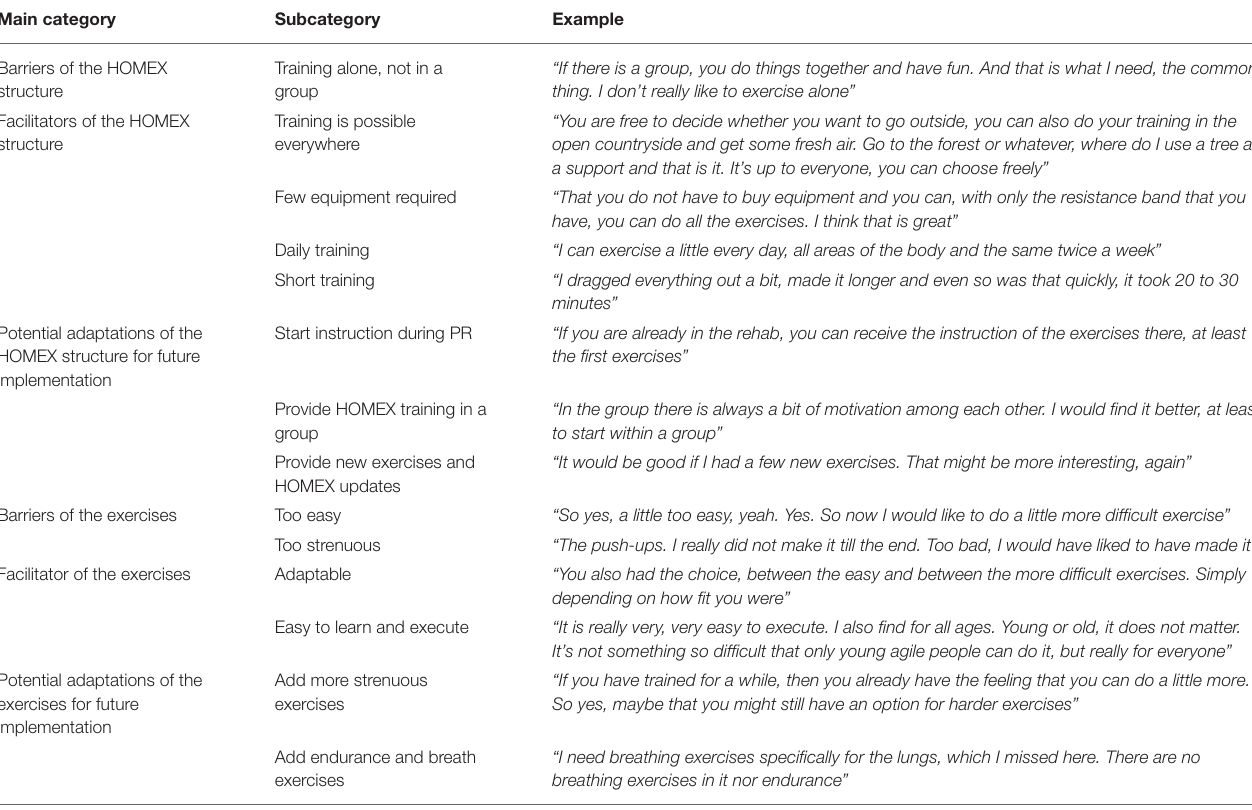
TABLE 4 | Results from interviews of patients: Overall structure and features of the HOMEX program.